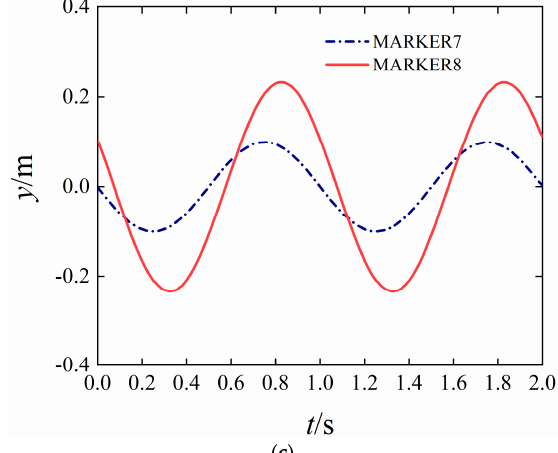
Figure 12. ( a ) The curve of combined displacement. ( b ) The curve of the horizontal displacement of the marked point with time. ( c ) The curve of the vertical displacement of the marked point with time.